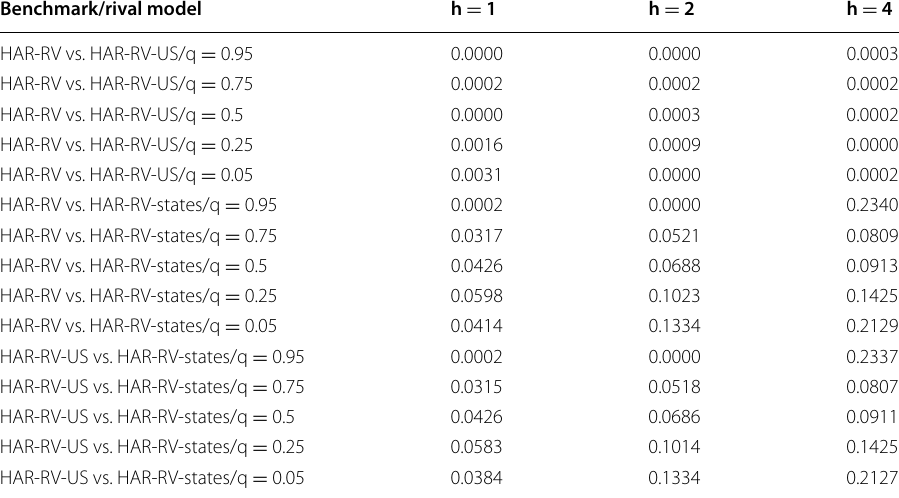
Table 3 Results for